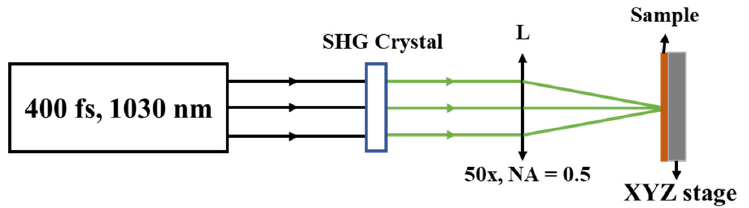
4 Figure 2. Optical setup for the direct writing of CGHs through photodissolution. The 532 nm con ‐ tinuous ‐ wave laser is expanded with 5× magnification using two achromatic lenses, L1 and L2, and shines a spatial light modulator (SLM). L3 and L4 are two additional achromatic lenses that image the SLM on the sample plane with a 1× magnification.